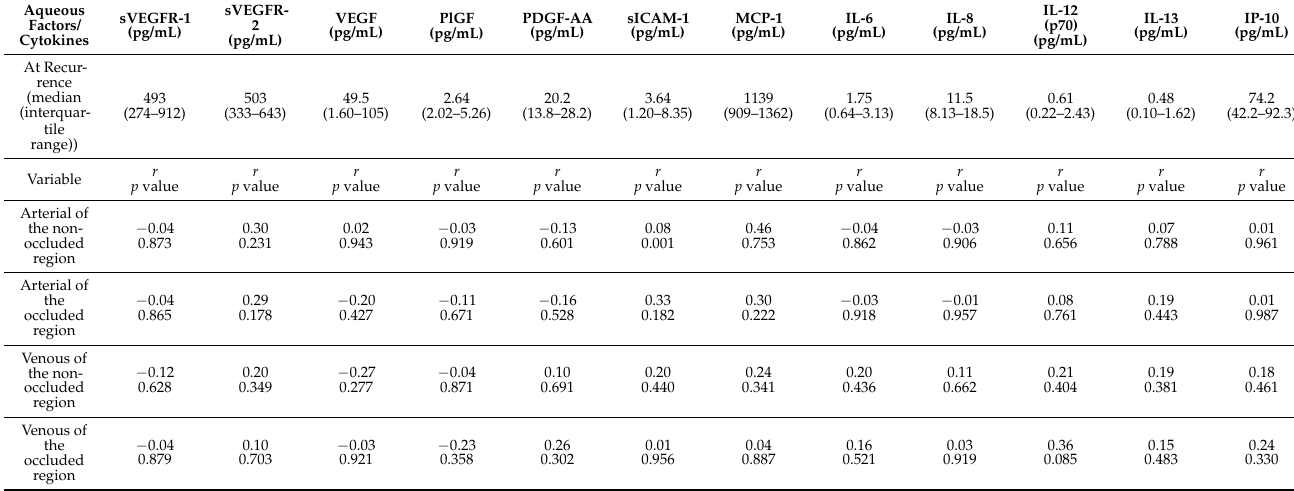
sVEGFR = soluble vascular endothelial growth factor receptor; VEGF = vascular endothelial growth factor; PlGF = placen- tal growth factor; PDGF = platelet-derived growth factor; sICAM = soluble intercellular adhesion molecule; MCP = mon- ocyte chemotactic protein; IL = interleukin; r = correlation coefficient. Spearman’s rank-order correlation coefficients were calculated.